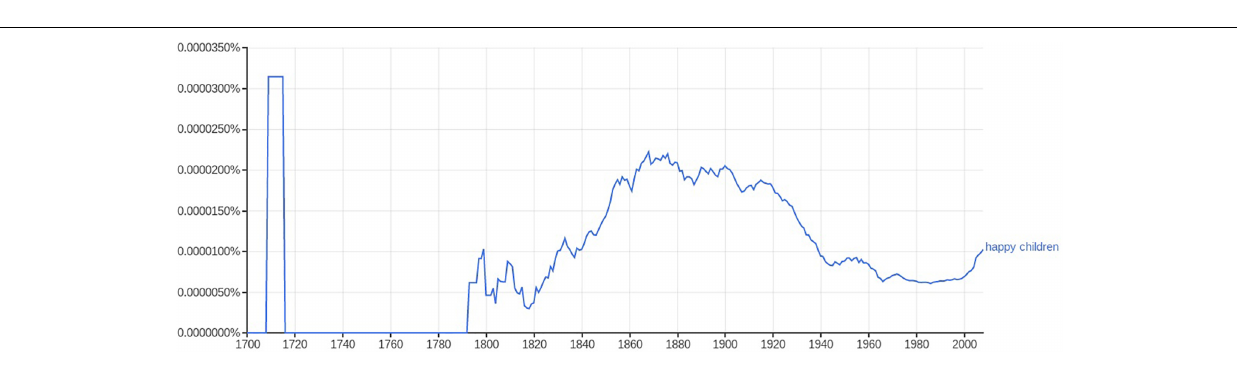
FIGURE 2 | Frequency of the phrase “happy children” in American English, 1700–2008, Google Ngram viewer, accessed March 19,